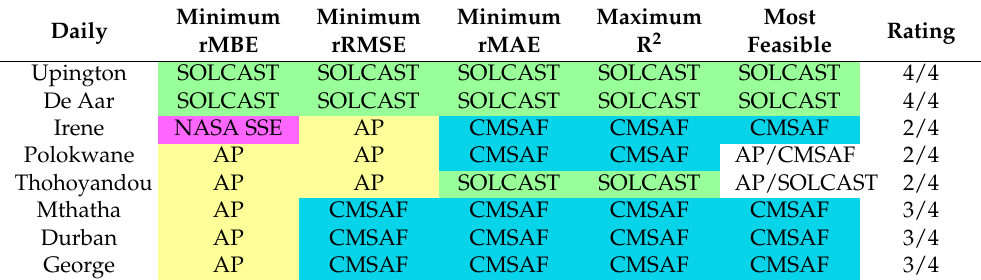
Table 4. Best estimated dataset per daily benchmark, most feasible dataset, and level of performance. Colors are used to show the best performing dataset each site based on daily benchmarks and the most feasible dataset per site based on degree of ranking out of 4 (total number benchmarks used). Green represents SOLCAST, magenta NASA SSE, blue CMSAF, and yellow AP.